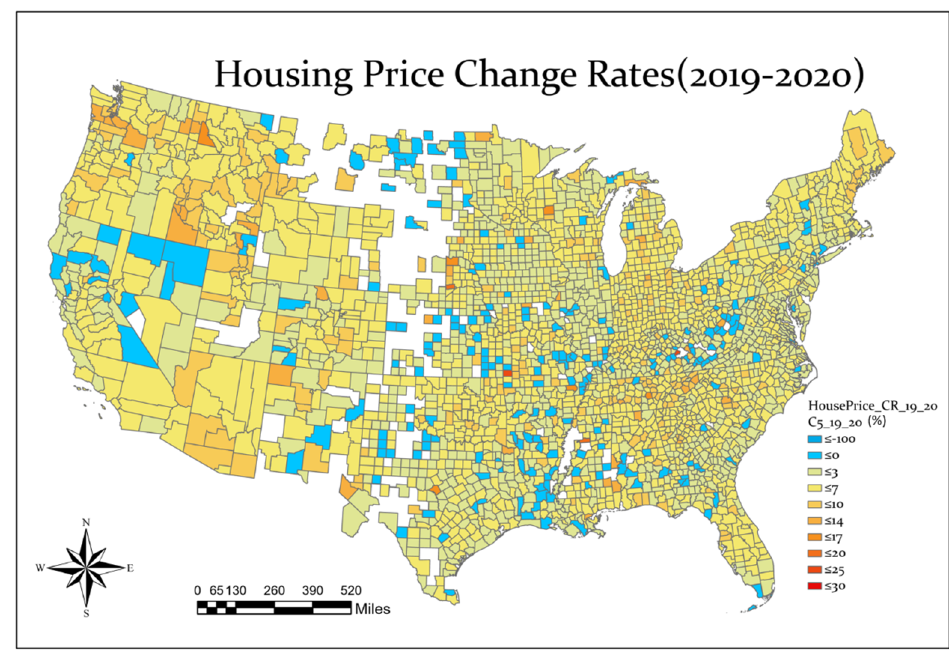
Figure 4. Housing price change rates during the nonpandemic year of 2019–2020 (from 1 May 2019 to 1 May 2020).